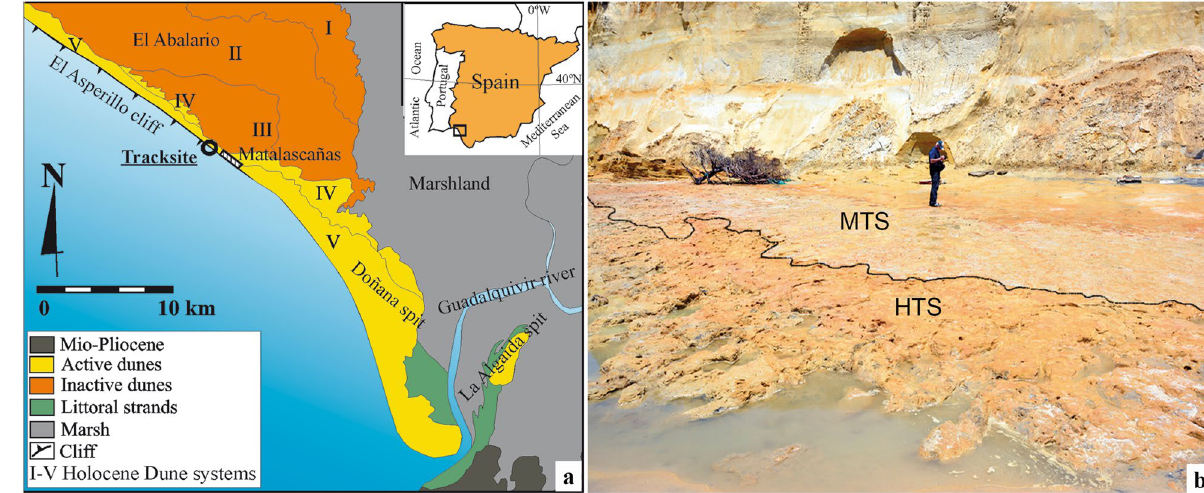
Figure 1. Location of Matalascañas site. ( a ) Geographic and geologic setting. Modified from Rodríguez- Ramírez et al. 16 . ( b ) Field view of the palaeosol PS2. MTS: Matalascañas Trampled Surface 14,15 . HTS: Hominin Trampled Surface (this